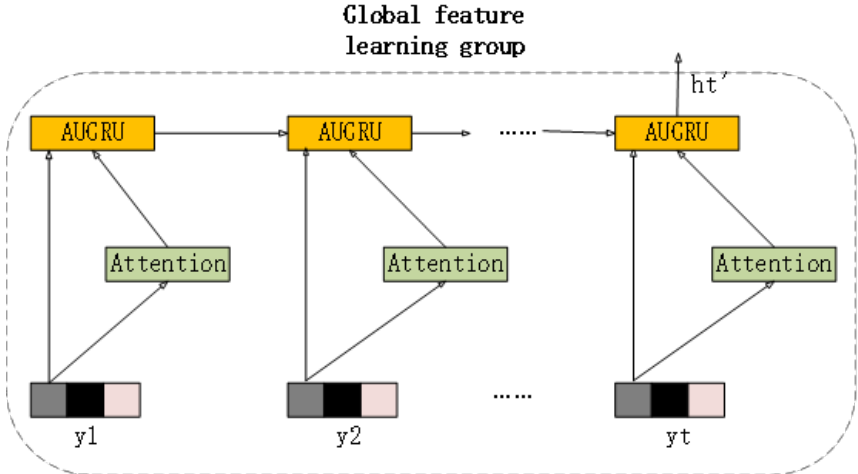
Figure 4. Global feature learning group framework diagram.